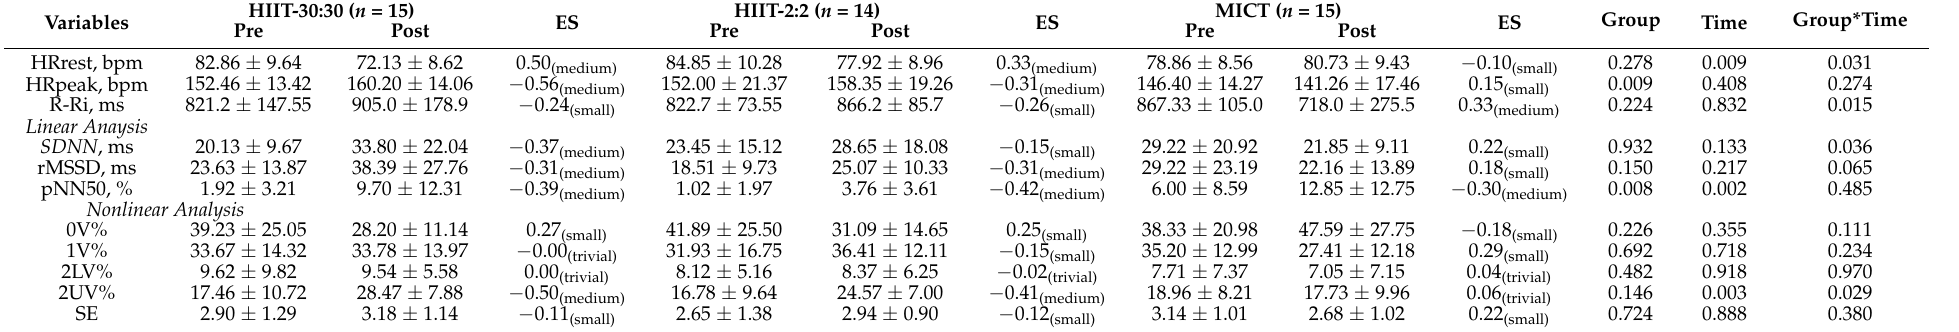
Table 2. Linear and symbolic analysis of heart rate variability in groups submitted to the intervention program.